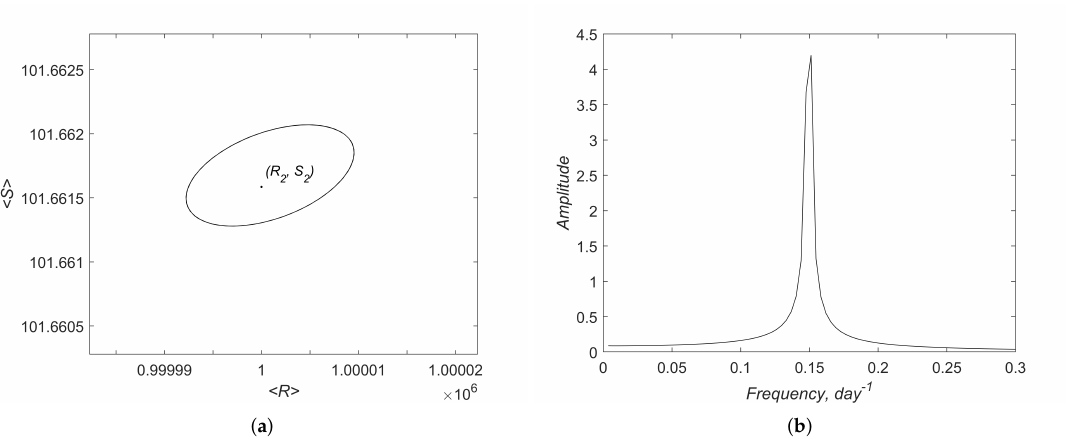
Figure A3. ( a ) Phase trajectory of model (7)–(10), (16) in the plane of spatially averaged values ( (cid:104) R (cid:105) , (cid:104) S (cid:105) ) . ( b ) The Fourier spectrum of the average prey density (cid:104) R (cid:105) . Parameters correspond to excitation of mode ( 2,4 ) (point B in Figure